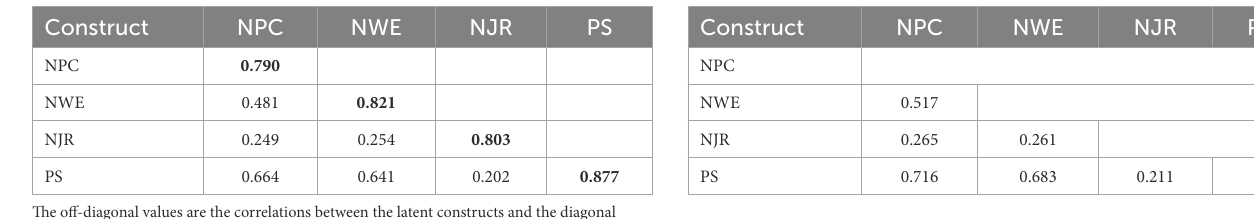
TABLE 5 Discriminant validity of the constructs—HTMT